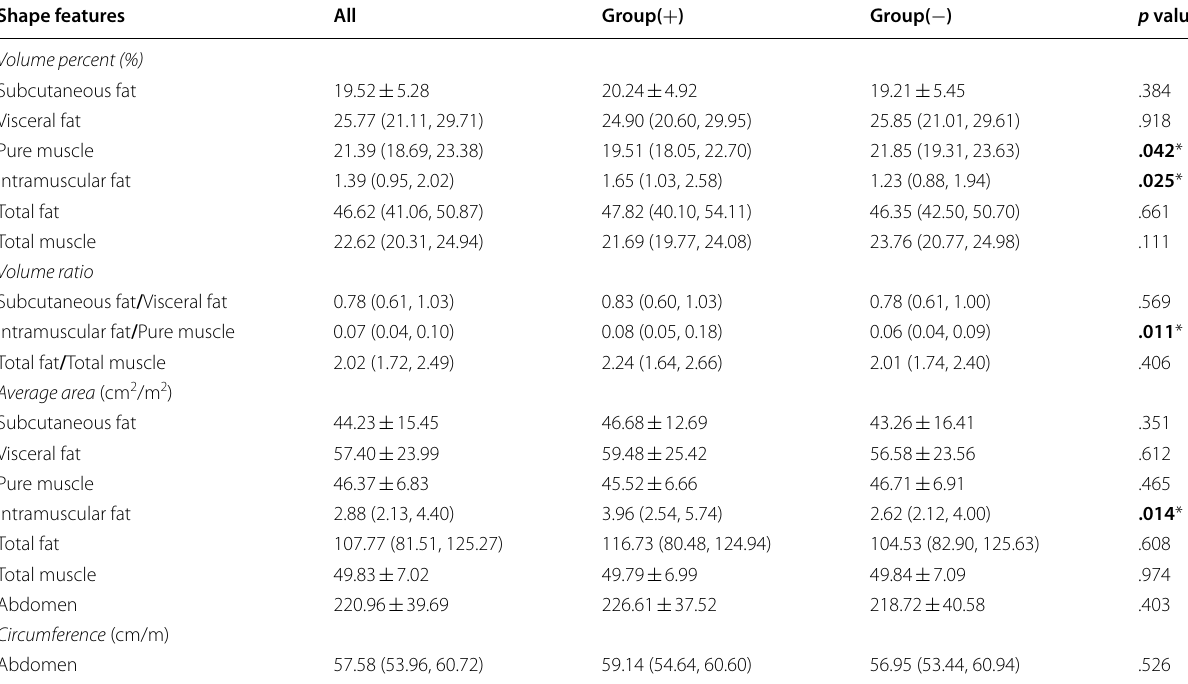
Table 2 Shape feature analysis of abdominal body